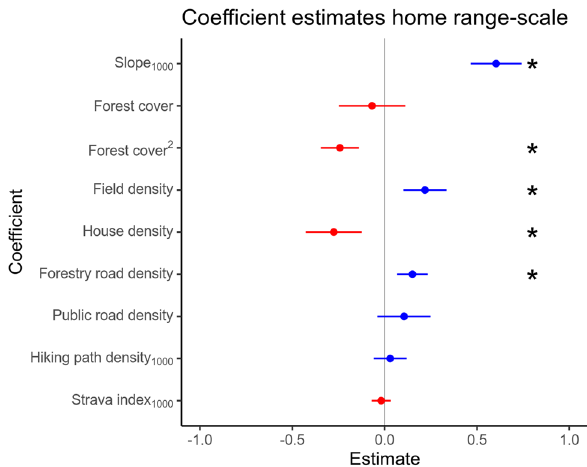
Figure 4. Selection coefficients for home range-scale habitat selection. Point estimates and 95% confidence intervals based on the robust standard errors for the home range-scale RSF models. Red colours indicate negative value of the estimate (i.e. avoidance) and blue colours indicate positive values of the estimate (i.e. selection). Stars indicate significant estimates at the alpha level of 0.05.